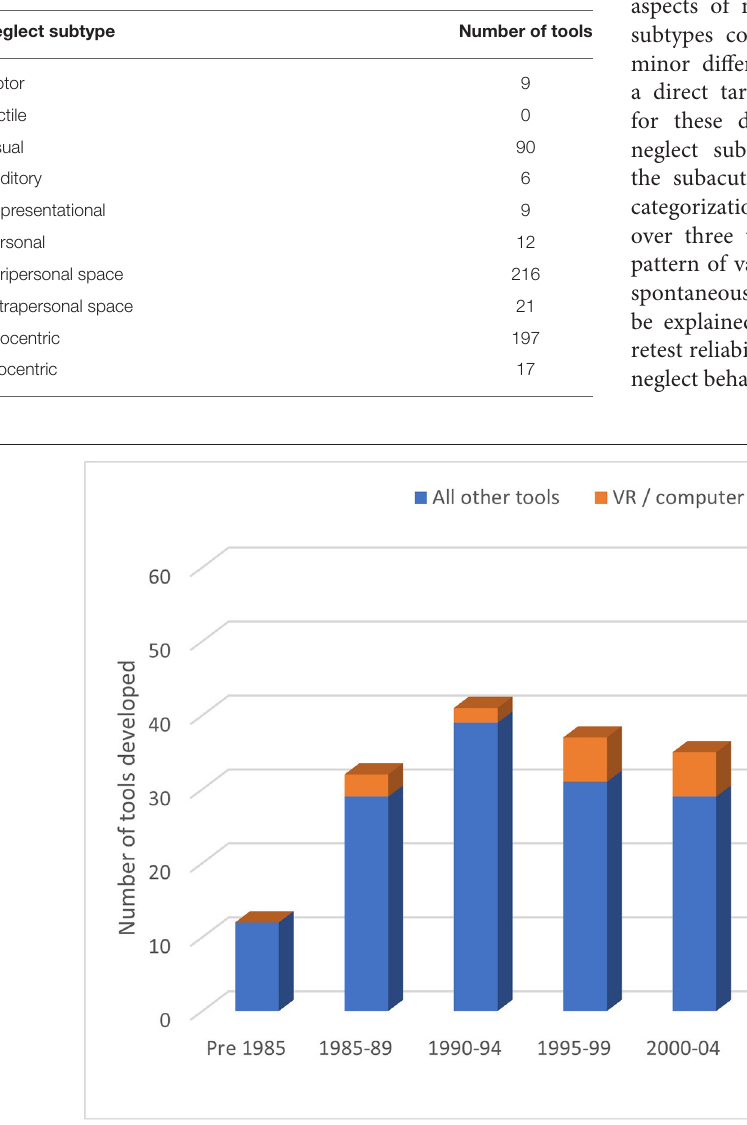
TABLE 3 | Standardized tools that can differentiate neglect subtypes.